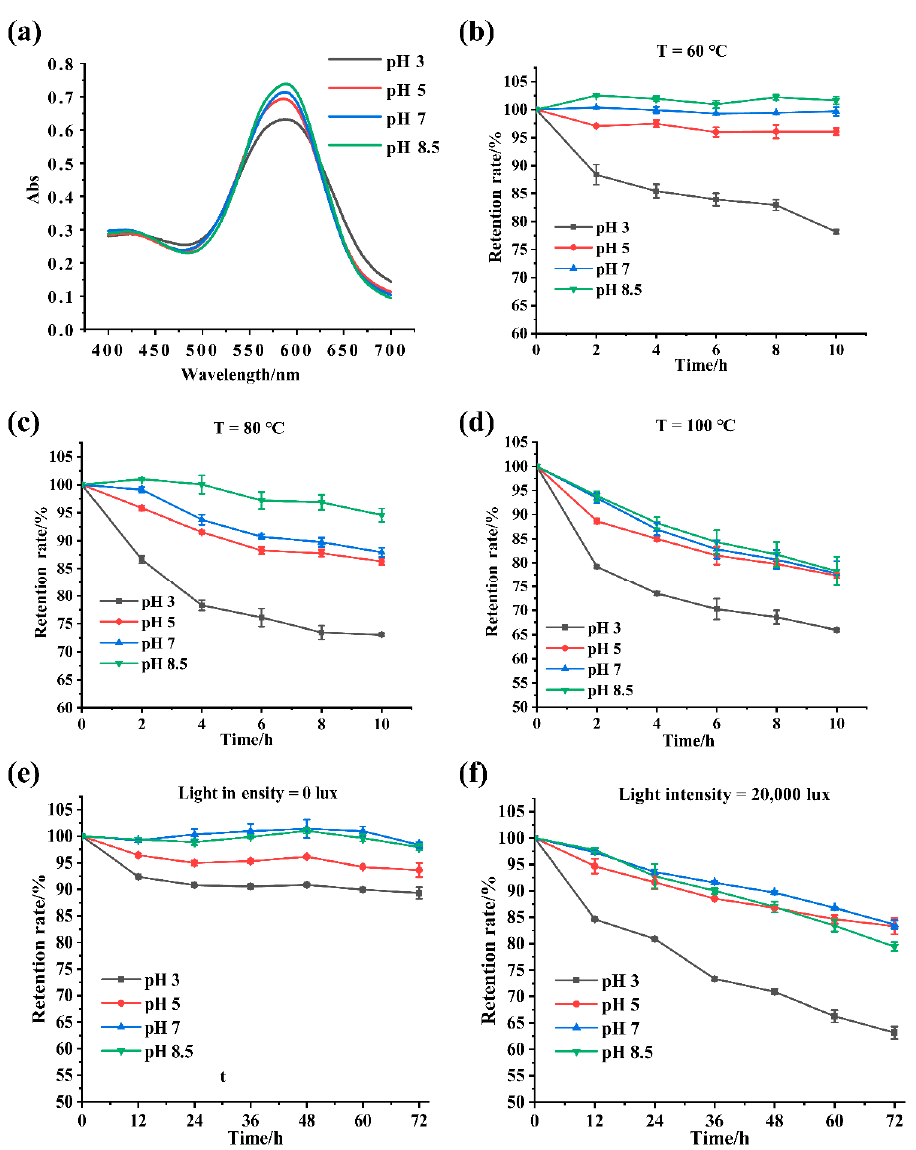
Figure 4. ( a ) The maximum absorbance of GBP reduced with decreased pH; the retention rate of GBP reduced with the reduction in pH at 60 °C ( b ), 80 °C ( c ), 100 °C ( d ), 0 lux ( e ), and 20,000 lux ( f ).